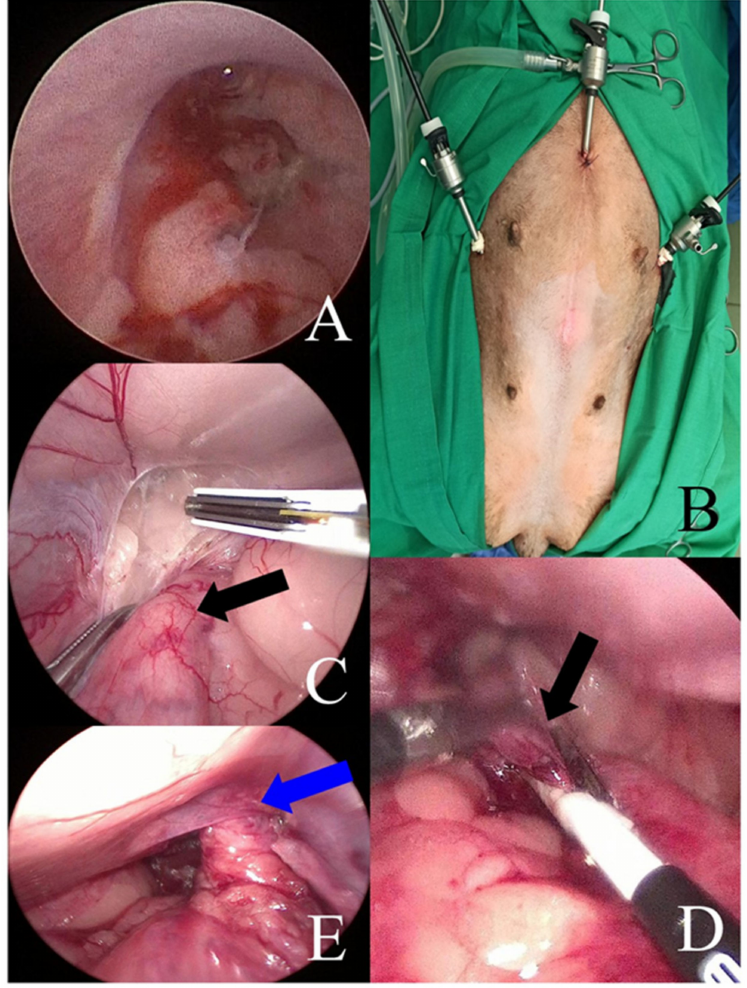
Figure 1. ( A ) Endoscopic image of transitional cell carcinoma tumor inside the lumen of the urethra. ( B ) Trocar system during hybrid surgery. ( C ) Laparoscopic intraoperative image of urethra dissection, black arrow—urethra. ( D ) Intraoperative endoscopic image of the urethra cut transversely (black arrow). ( E ) Intraoperative laparoscopic image of the urethrostomy site (blue